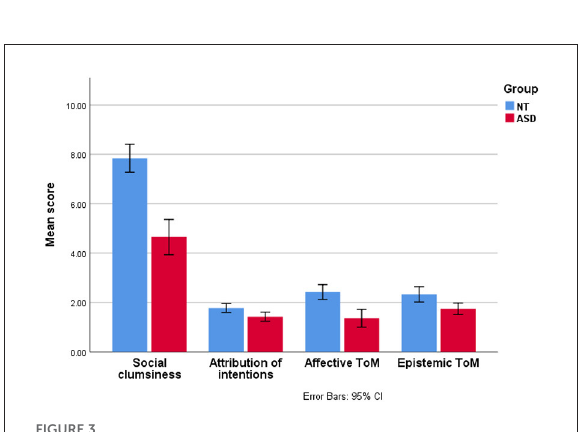
FIGURE3 Theory of Mind subdomain scores in children with autism spectrum disorder vs. in neurotypical